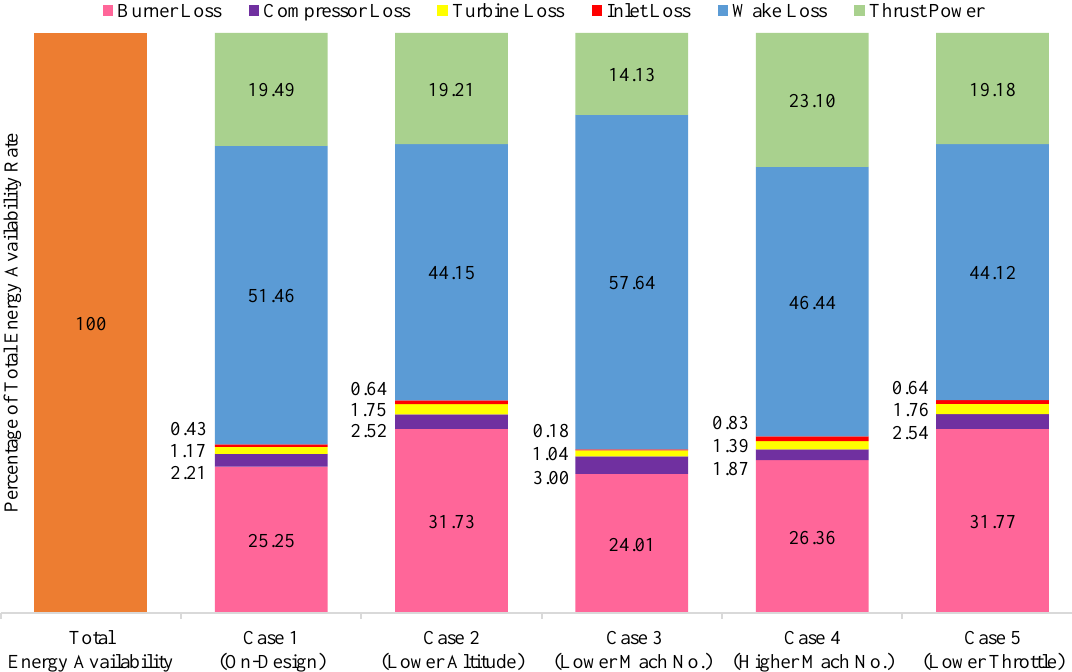
Figure 3. Comparative energy availability breakdown for the different engine operating conditions. Table 3. Comparative parameter values for engine on- and off-design operations.